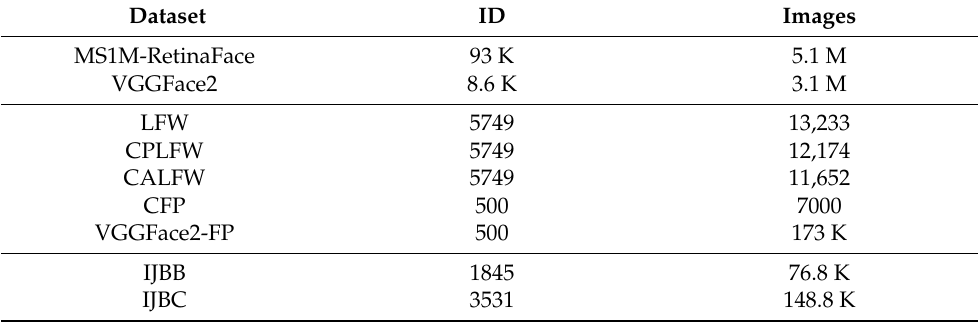
Table 4. Statistical information on the datasets